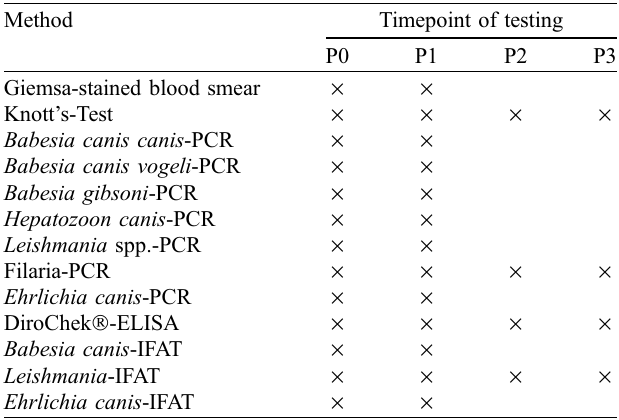
Table 1. Pre- and post-travel screening panel for arthropod-borne